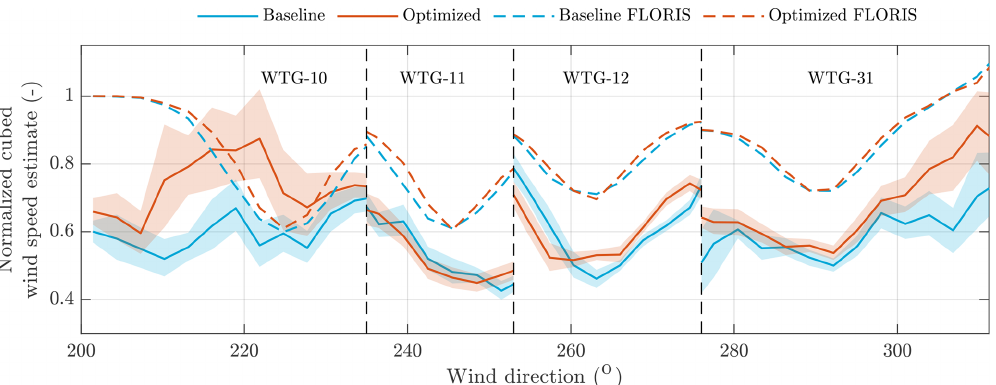
Figure 10. The cubed wind speed estimates of the downstream WTG of interest, serving as a surrogate for the power production under turbine derating. The results are normalized with respect to WTG 25. The shaded areas show the 95% confidence bounds. FLORIS underpredicts the wake losses. Moreover, the optimized dataset appears to outperform the baseline dataset, showing a benefit due to wake steering. The number of samples in each bin is shown in Fig. 7.